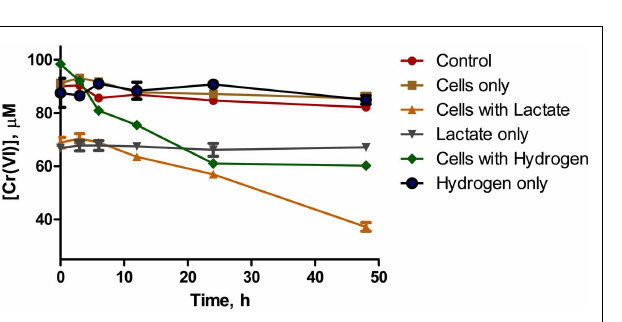
FIGURE 4 | Chromate reduction in cultures of D. desulfuricans (left panel) and S. barnesii (right panel) for live bacteria ( (cid:78) ) and heat killed bacteria ( as compared to the uninoculated SES3 medium ( ⊕ or (cid:3) ). The spline curves are non-linear fit of the data from which the rate values were calculated.